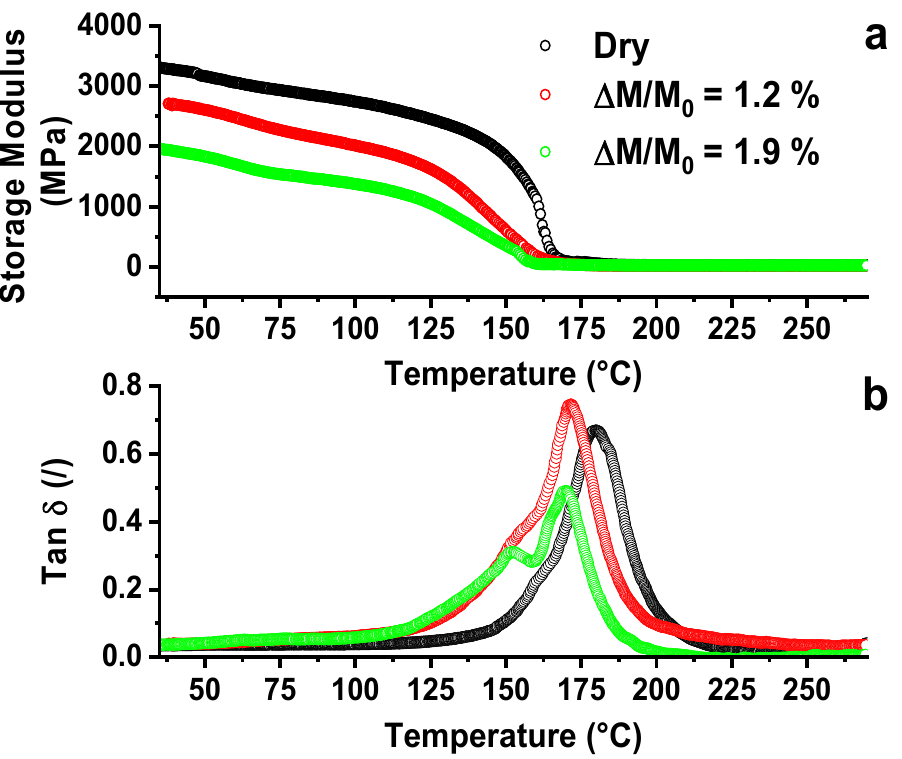
Figure 2. ( a ) Storage modulus and ( b ) tan δ of the filled epoxy with 0.1% by weight of CNTs at different ∆ M/M 0 values.